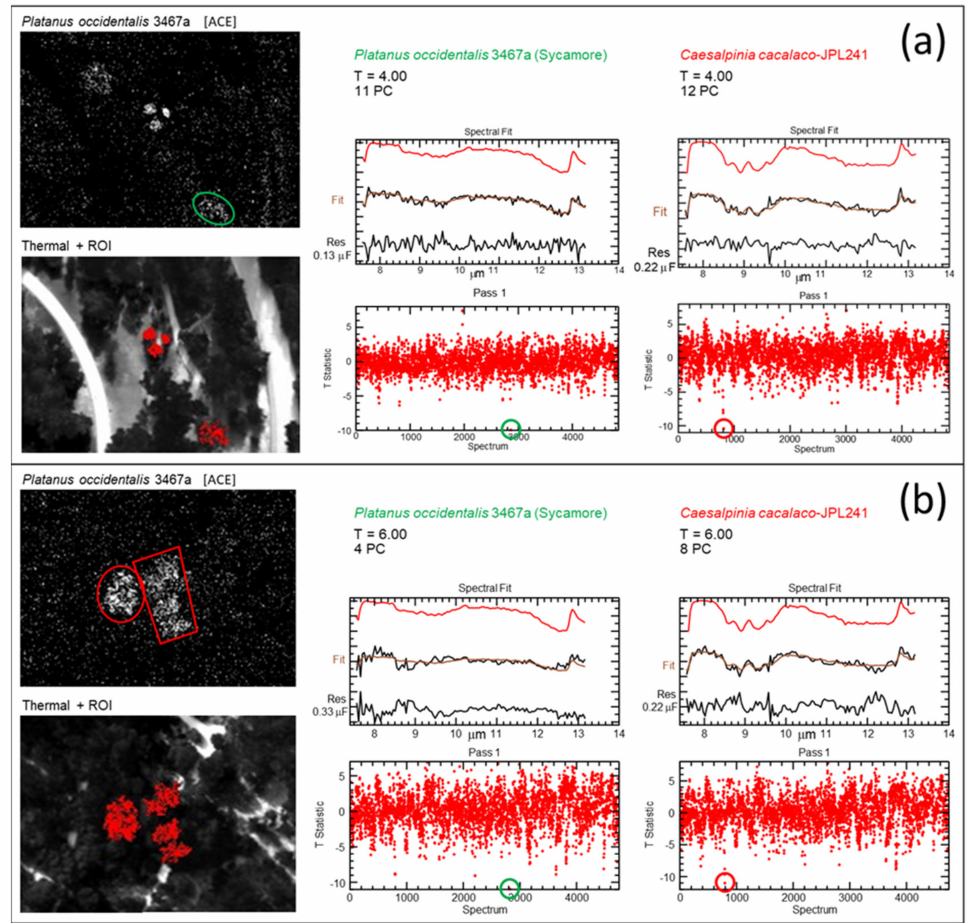
Figure 19. ( a ) Mis-ID of Platanus racemosa group at Lacy Park. A P. occidentalis specimen (encircled at bottom of frame) is positively ID’d. ( b ) Mis-ID of P. x acerifolia group at Descanso